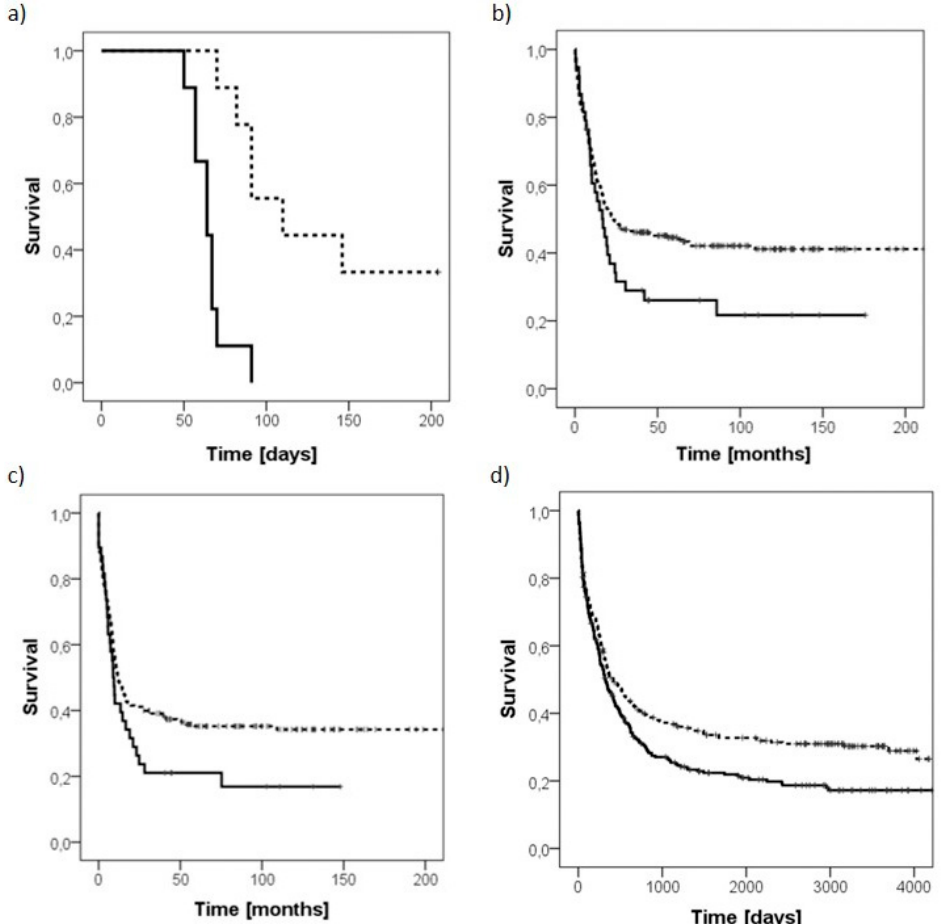
Figure 3. High PLS3 expression is associated with a poor prognosis. ( a ) Kaplan–Meier survival curve of NSG mice transplanted with PLS3-knockdown (dashed line) or control Kasumi-1 cells (continuous line; n = 9 mice per group; p < 0.001). ( b , c ) A clear difference for high PLS3 expression (continuous